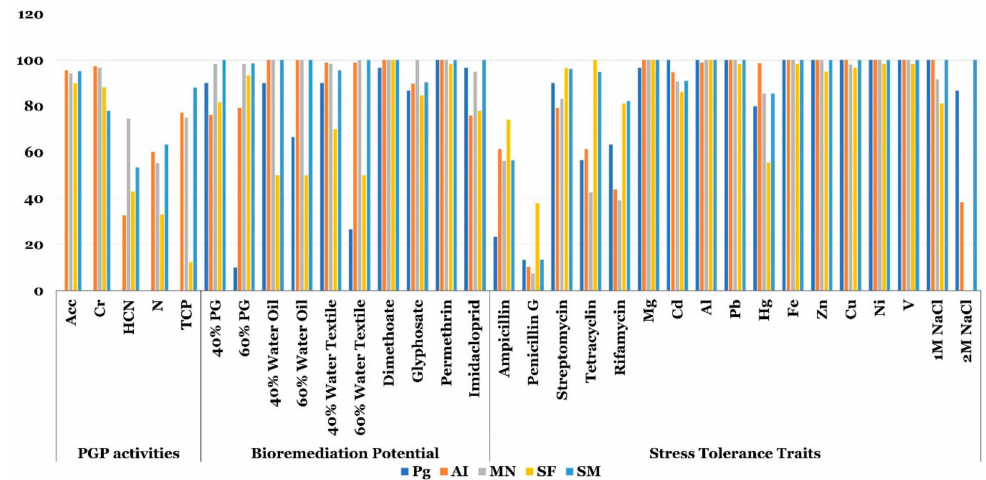
Figure 7. Bar chart showing PGP activities prevalence, bioremediation and stress tolerance traits of culturable Phosphogypsum and plant